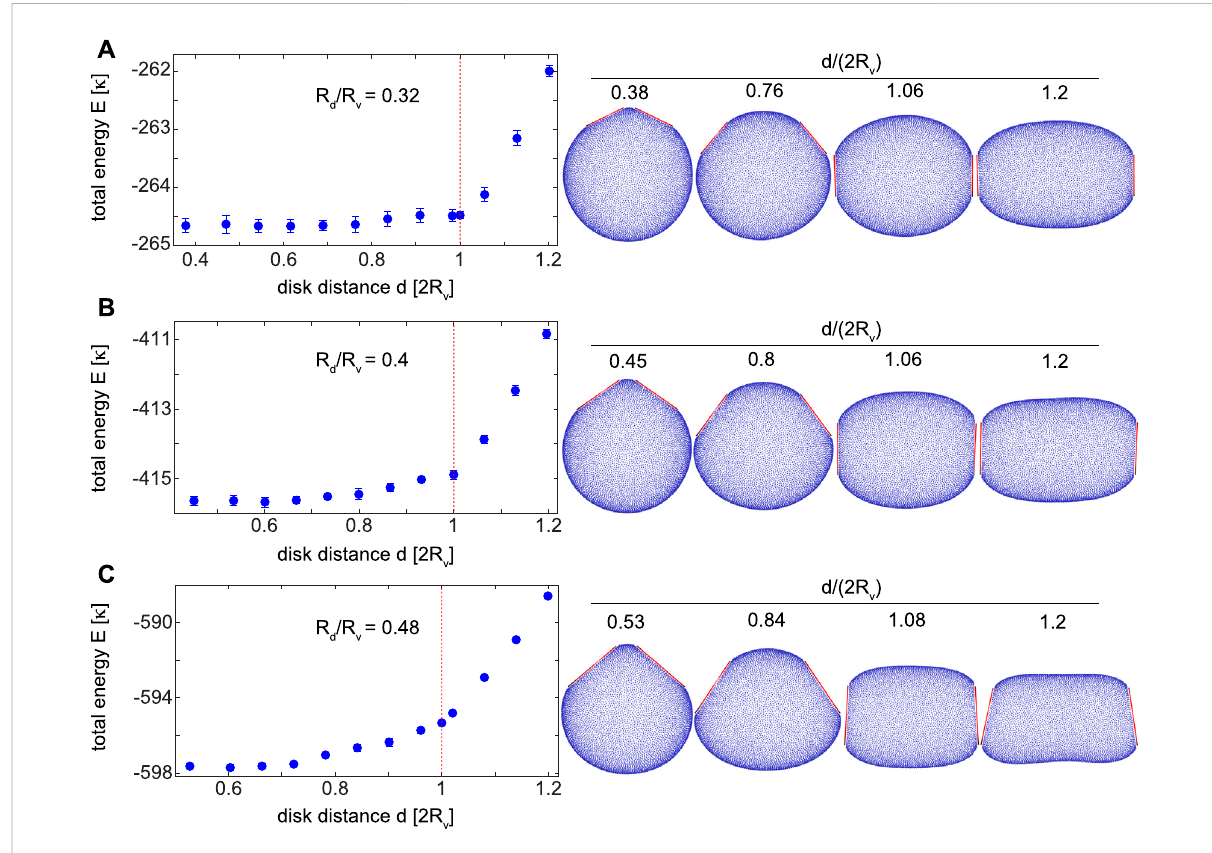
FIGURE 3 The total energy E / κ of a spherical vesicle with disk sizes (A) R d / R v =0.32, (B) R d / R v =0.4, and (C) R d / R v =0.48 with corresponding vesicle shapes in the right panels. Each point re fl ects the mean and the standard deviation of the total energy from ten simulations. For large disk sizes R d / R v > 0.3, both short and long-range interactions are attractive as shown for disk distances below and beyond the vesicle diameter 2 R v i.e. the red dotted